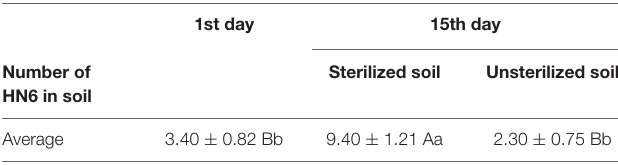
TABLE 2 | Colonization ability of strain HN6 in soil ( × 10 4 cfu g − 1 soil − 1 ).